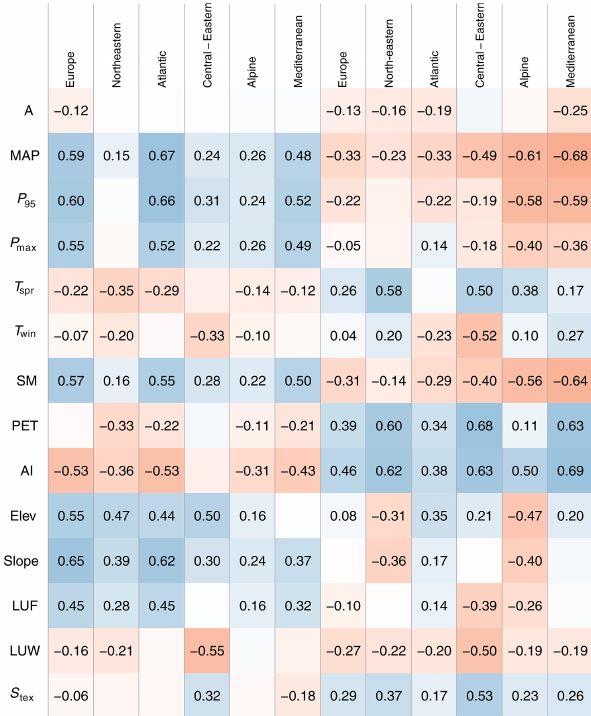
Figure 6. Spearman correlation between statistical moments of flood series (mean specific discharge normalized to a catchment area MAF α of α = 100km 2 and the CV and catchment attributes. Correlations are shown if they are statistically significant ( α = 0 . 05). Blue and red indicate positive and negative relationships, re- spectively. The correlations for mean specific discharge MAF and coefficient of skewness CS with catchment attributes are given in Table